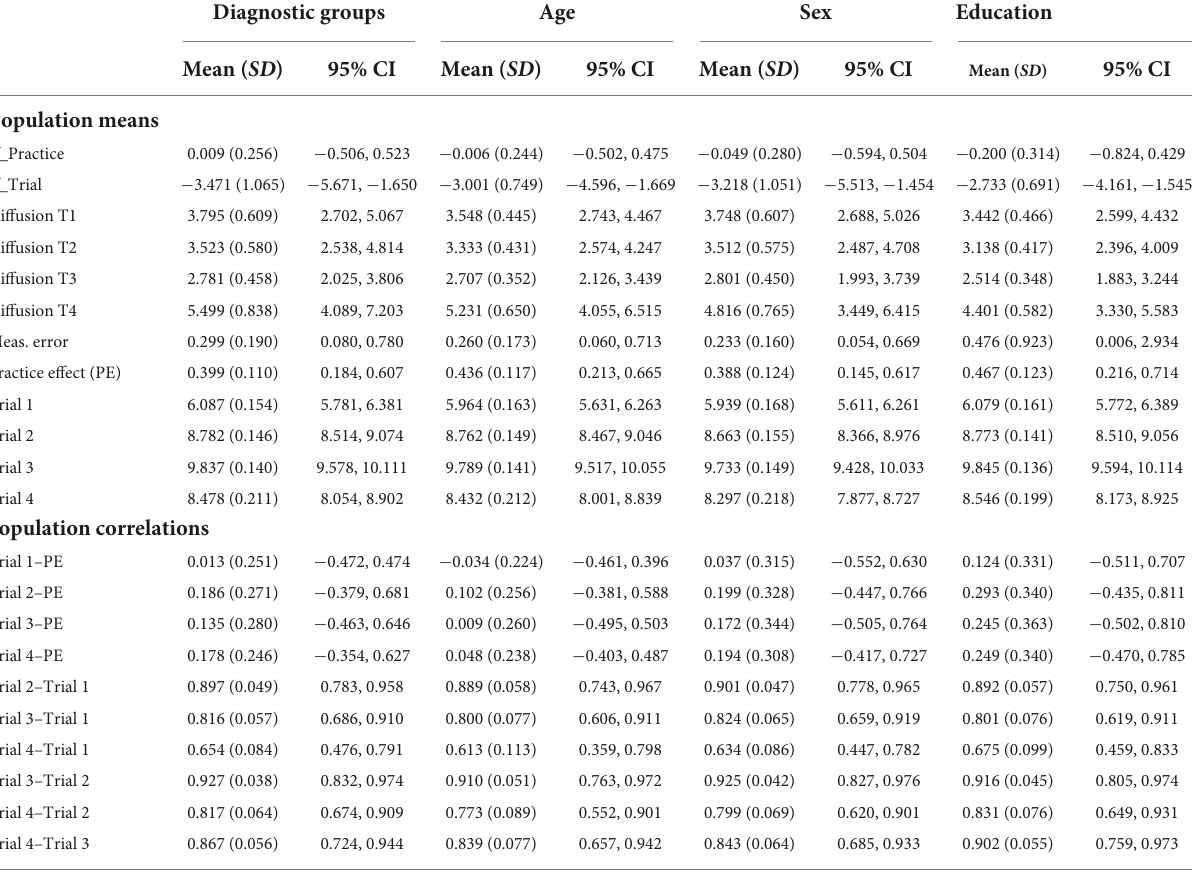
TABLE 3 Estimated population mean values and correlations for diagnostic group and sensitivity